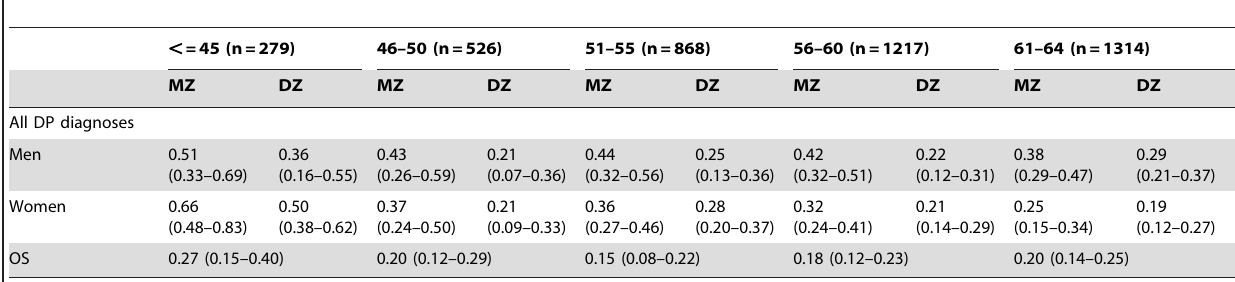
Table 4. Within-pair correlations for liability (95% CI) to disability pension (DP) among women and men, by age group and